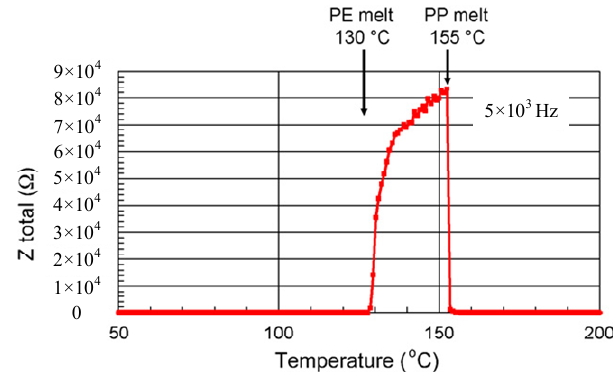
Figure 6. Melting temperature of PE/PP separator material [50].